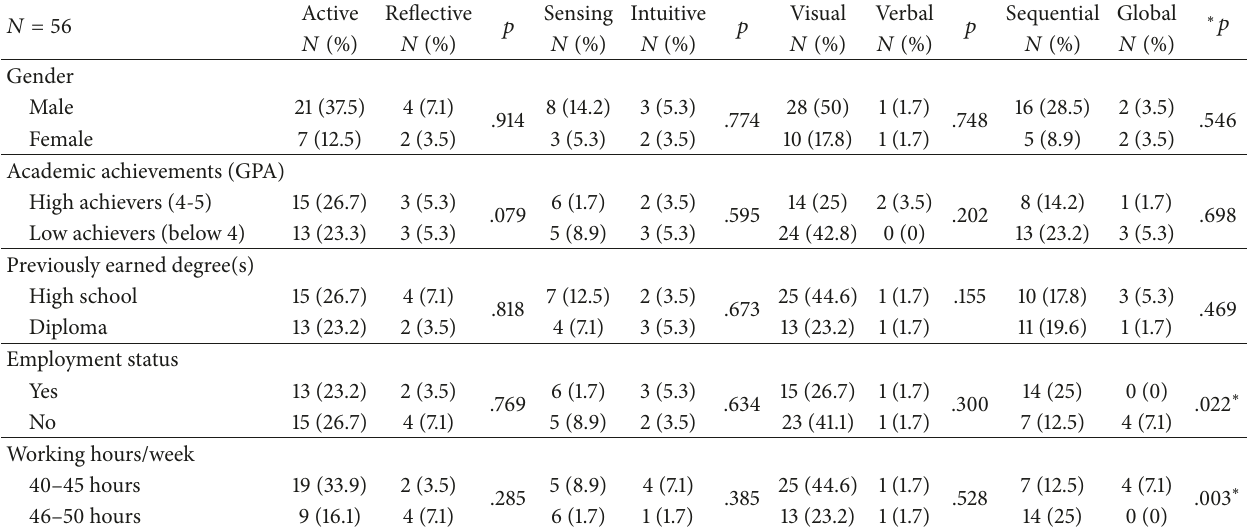
Table 3: Distribution and association of participants’ learning styles according to gender, academic achievement, qualification, employment status, and working